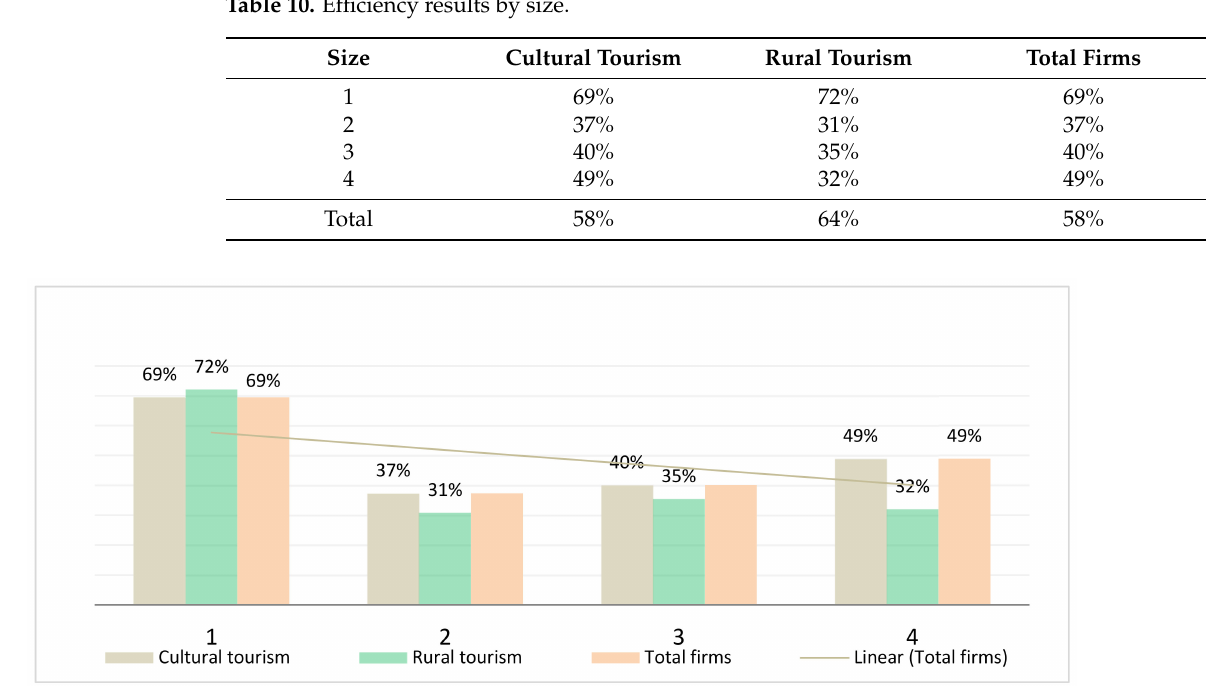
Figure 8. Efficiency results by